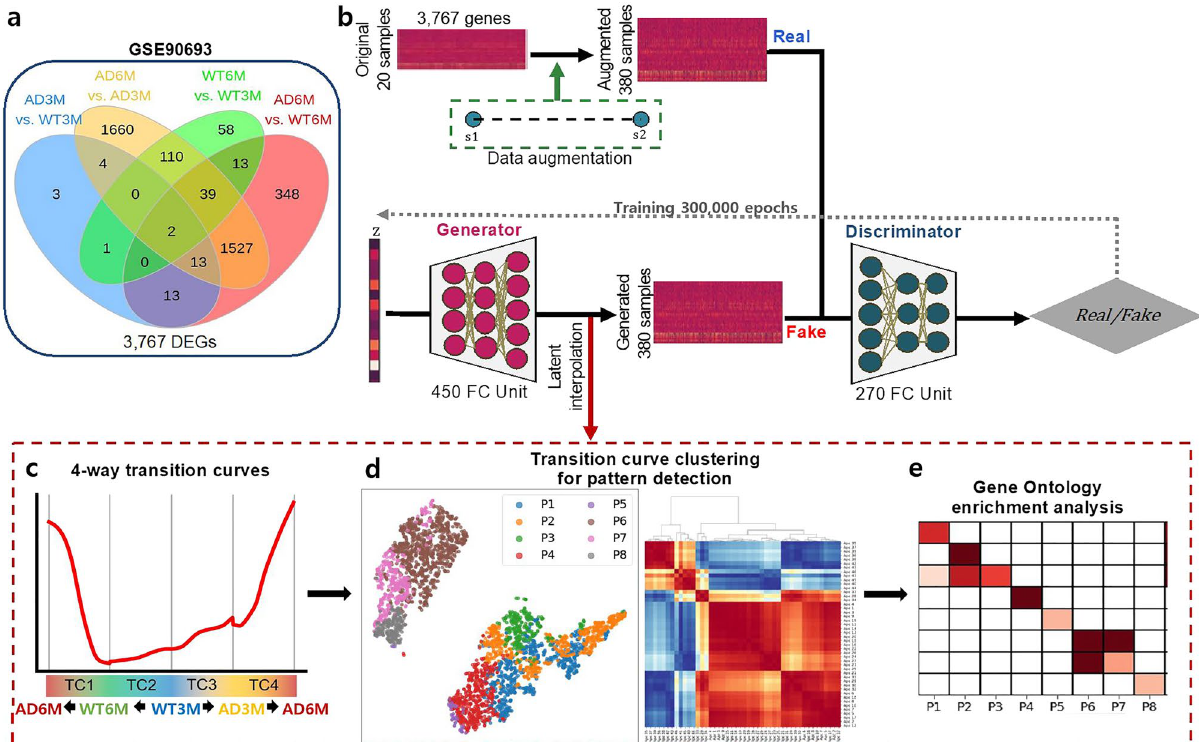
Figure 1. Schematic overview of GAN training and workflow of downstream analyses. ( a ) Venn diagram of DEGs in four comparative pairs from bulk RNA-seq data (GSE90693). ( b ) The generative adversarial network consists of two neural networks simultaneously training and competing against each other (see Supplementary Fig. 2). ( c ) Representation of four-way TCs: TC1 (late phenotype changes, WT6M → AD6M), TC2 (WT maturation, WT3M → WT6M), TC3 (early phenotype changes, WT3M → AD3M), and TC4 (AD maturation, AD3M → AD6M). ( d ) Four-way TCs are clustered and grouped according to pattern similarities. ( e ) Gene Ontology enrichment analysis by TC pattern. AD, Alzheimer’s disease; DEGs, differentially expressed genes; FC, fully connected layer; GOBP, Gene Ontology biological process; M, months; P, pattern group; TC, transition curve; WT, wild